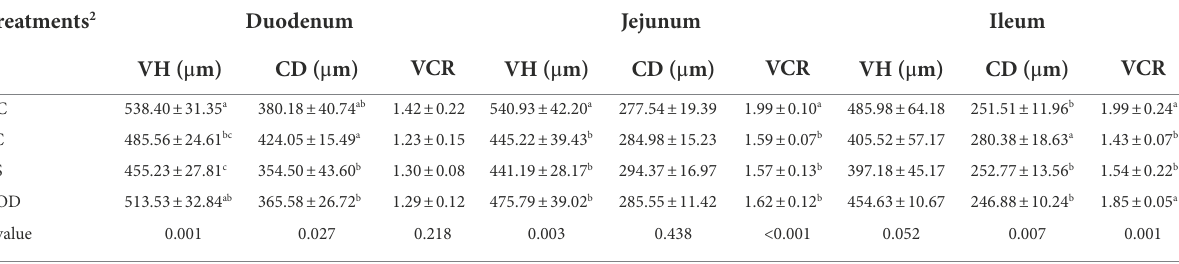
TABLE 7 Effect of dietary treatments on intestinal morphology 1 in piglets challenged by enterotoxigenic Escherichia coli (ETEC). Treatments